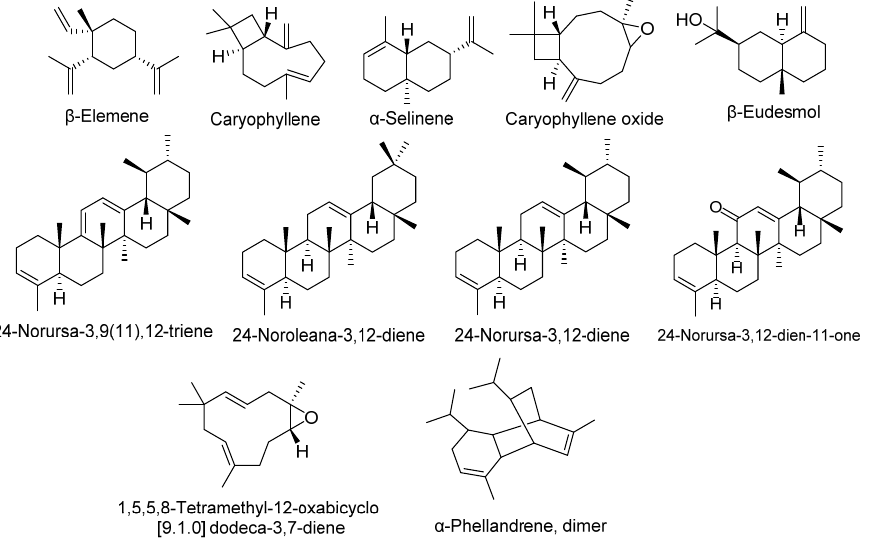
Figure 2. Common compounds identified in all parts of the O. arabicus.